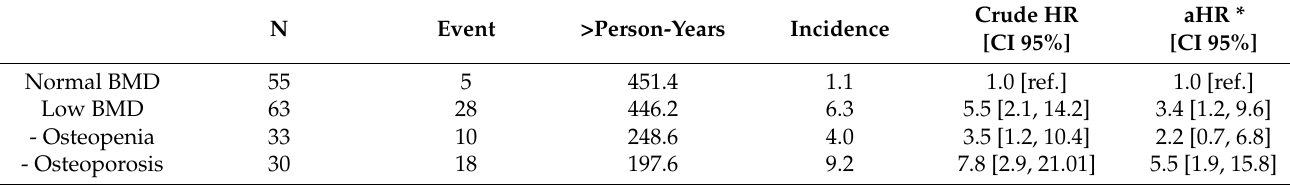
Table 2. Overall rate of